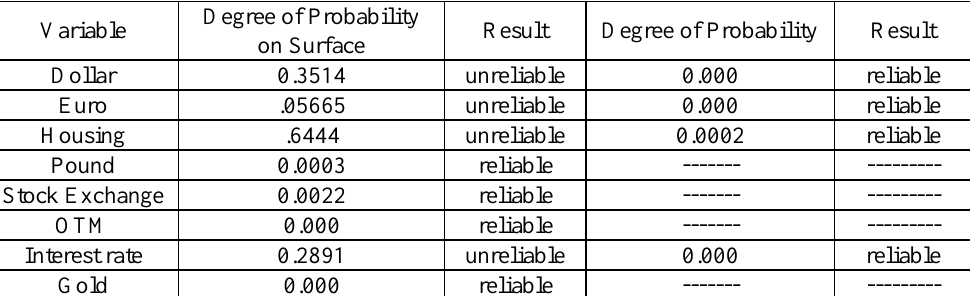
Table 2. Reliability Test of